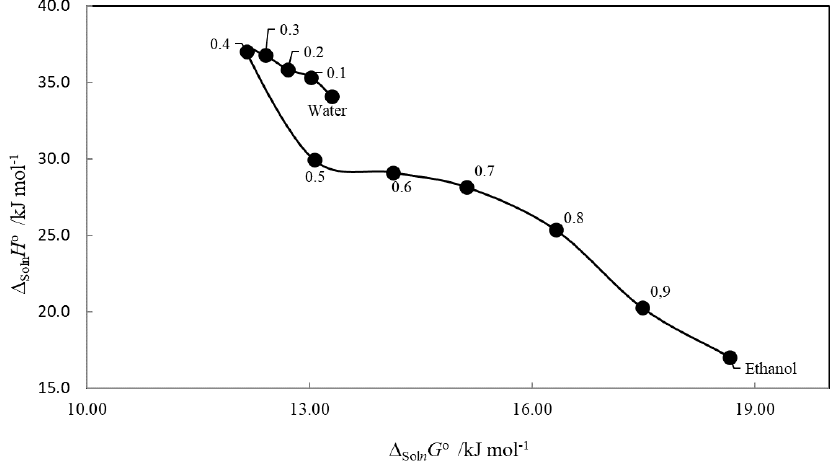
Figure 5. Enthalpy–entropy compensation graph of ∆ soln H o vs. ∆ soln G o at T hm = 310.22